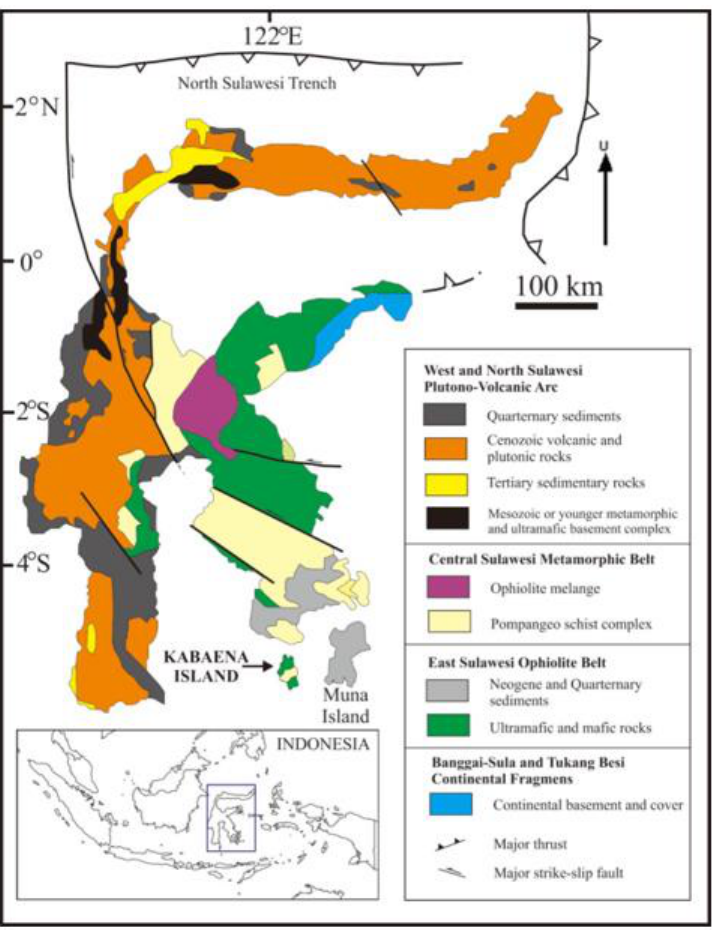
Figure 1. Geological sketch map of Sulawesi showing the location of Kabaena Island (simplified after Hamilton [9] and Kadarusman et al. [10]).